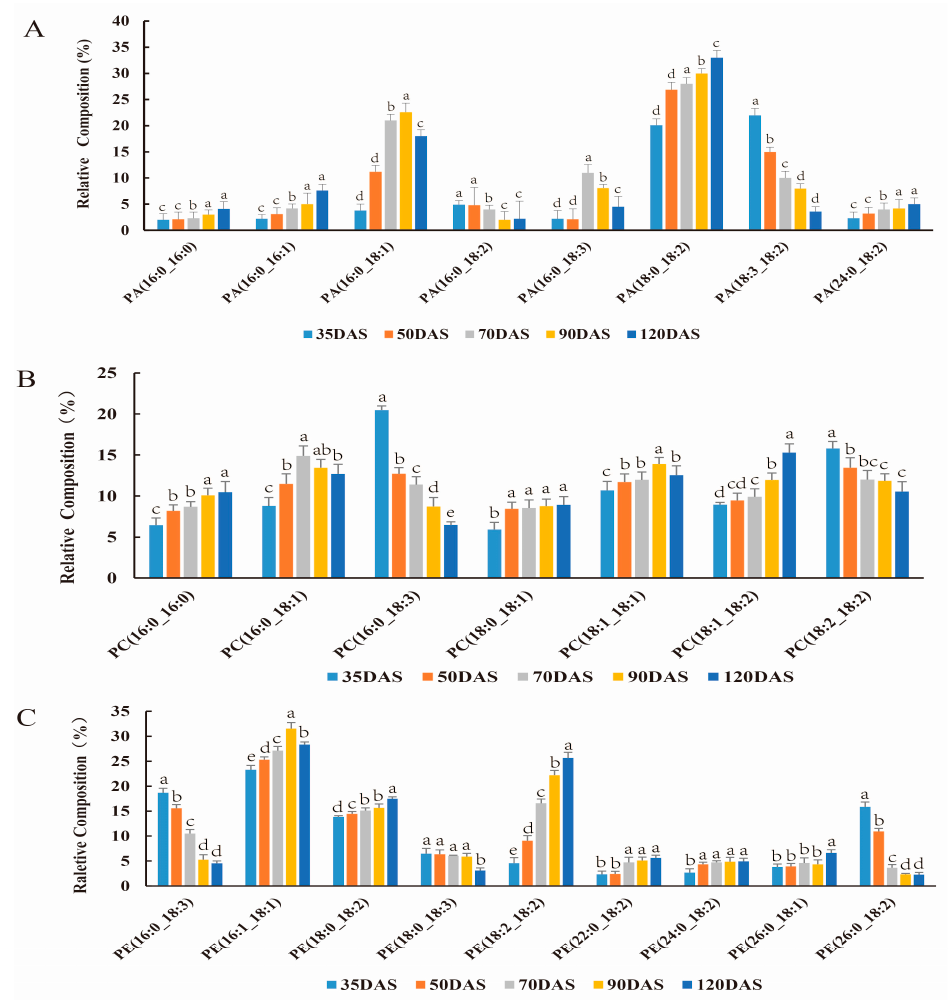
Figure 4. Profiling of different molecular types of phospholipids during tuber development. Phosphatidic ( A ), phosphatidylcholine ( B ), and phosphatidylethanolamine ( C ) molecular types were separated by LC/MS as detailed in Materials and methods. Data indicate means ± SD ( n = 6)